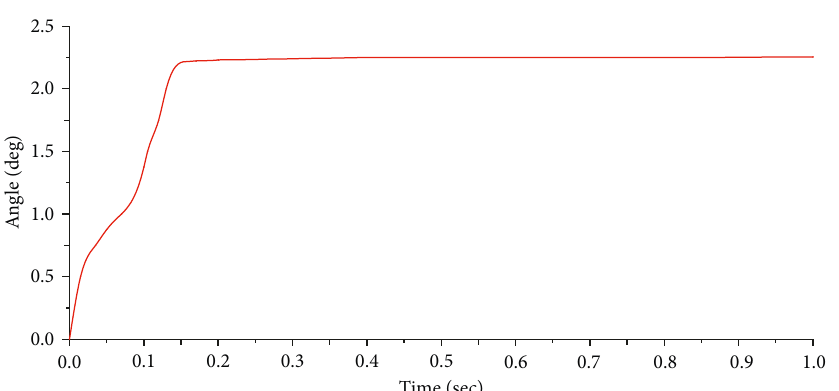
Figure 9: The curve of the axis swing angle of the output flange during the disengagement of the crown gear coupling.